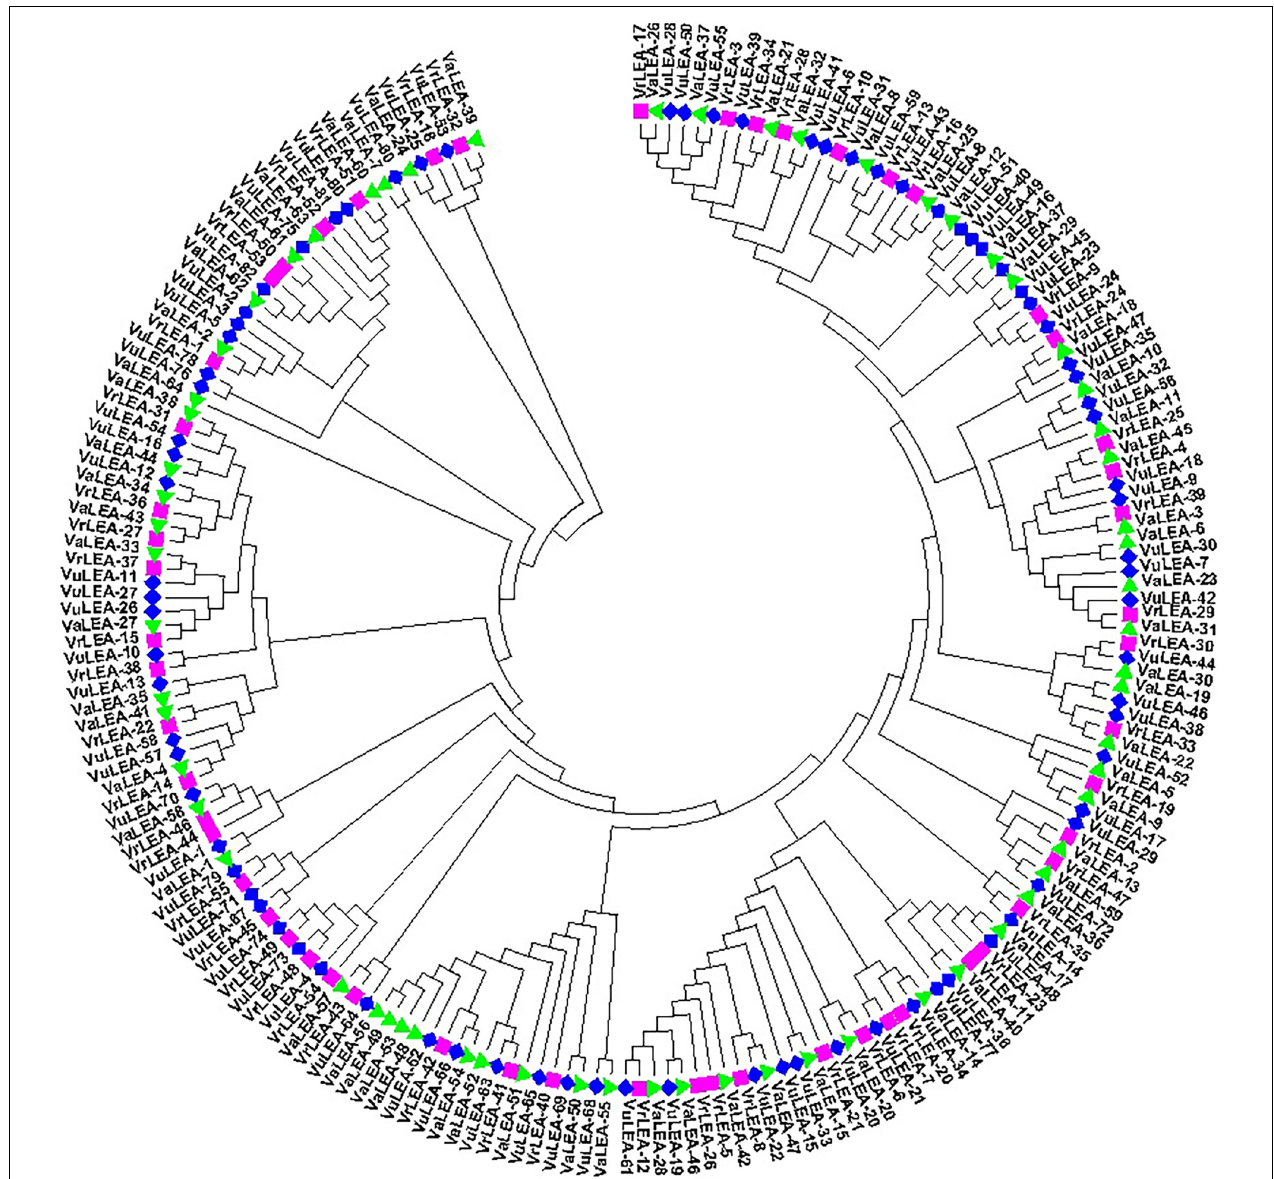
FIGURE 2 | Phylogenetic relationship of VrLEA , VaLEA , and VuLEA